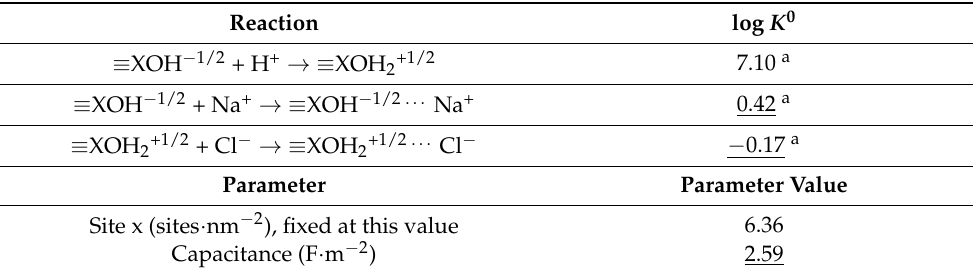
Table 1. Parameters and reactions used to model the amphoteric behavior of the Fe(III) mineral surface with an electrostatic (Basic Stern) SCM model at infinite dilution and zero surface potential. Fitted parameters are